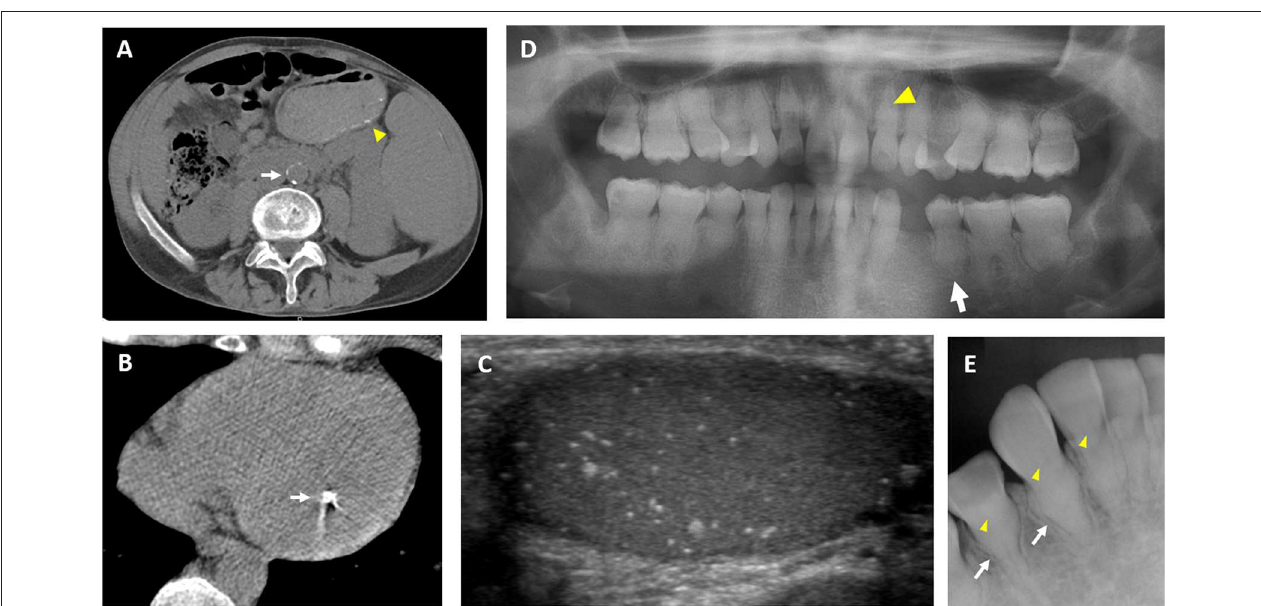
FIGURE 3 | Clinical images of extraskeletal features in hyperphosphatemic tumoral calcinosis. (A) Computed tomography scan from a 36-year-old man demonstrates calcification in the abdominal aorta (white arrow). Small submucosal bowel calcifications are also visible (yellow arrowhead). (B) Computed tomography scan of the heart in a 29-year-old man demonstrates a calcified lesion in the papillary muscle (arrow). (C) Testicular ultrasound from a 32-year-old man showing diffuse microlithiasis. (D) Panoramic dental radiograph from an 18-year-old woman shows teeth with short, bulbous roots (white arrow) and obliteration of dental pulp (yellow arrowhead). (E) Periapical dental radiograph from a 12-year-old girl shows thistle-shaped root (white arrows) and obliteration of dental pulp (yellow arrowheads). These figures are original, and have not been previously published or obtained from a private database. There is no unpublished data in any of the